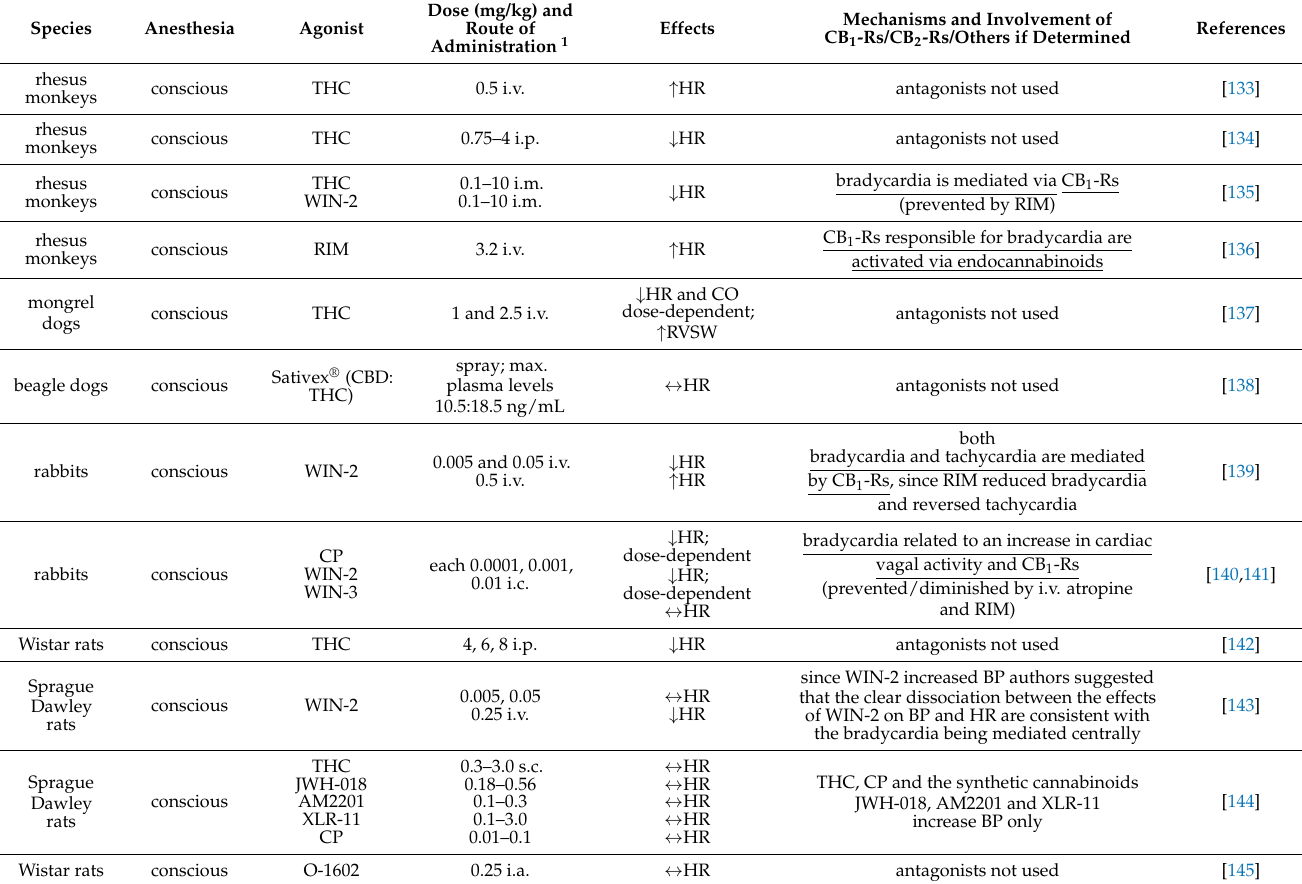
Table 3. Cardiac effects of acute cannabinoid administration in experimental animals in